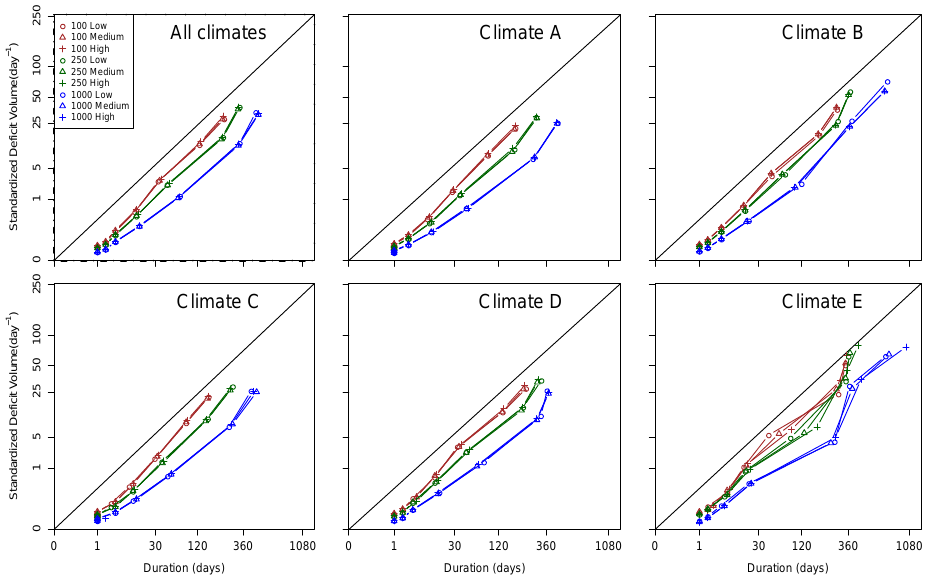
Fig. 6. Drought duration and standardized deficit volume (5, 10, 25, 50, 75, 90 and 95 deciles) for three soils and three different groundwater systems lumped for all climates and for each of the five K¨oppen–Geiger major climate types (A–E). The circles represent extreme events beyond D95 for the 96, 97, 98, 99 and 100 deciles. Please note that y-axis is on log